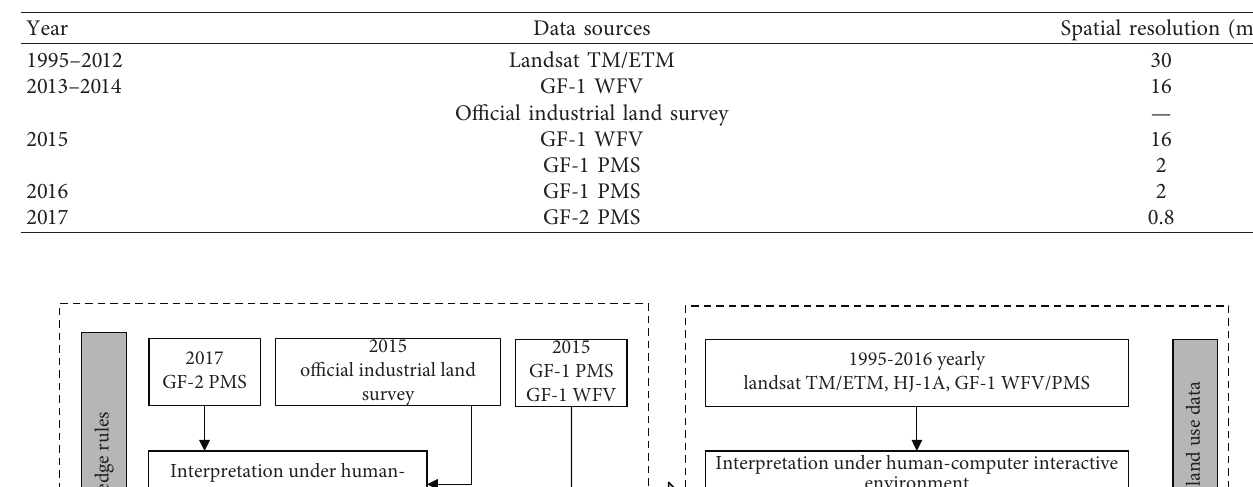
Figure 2: Geographical location of the Shunde district. Table 1: Remote sensing data of the